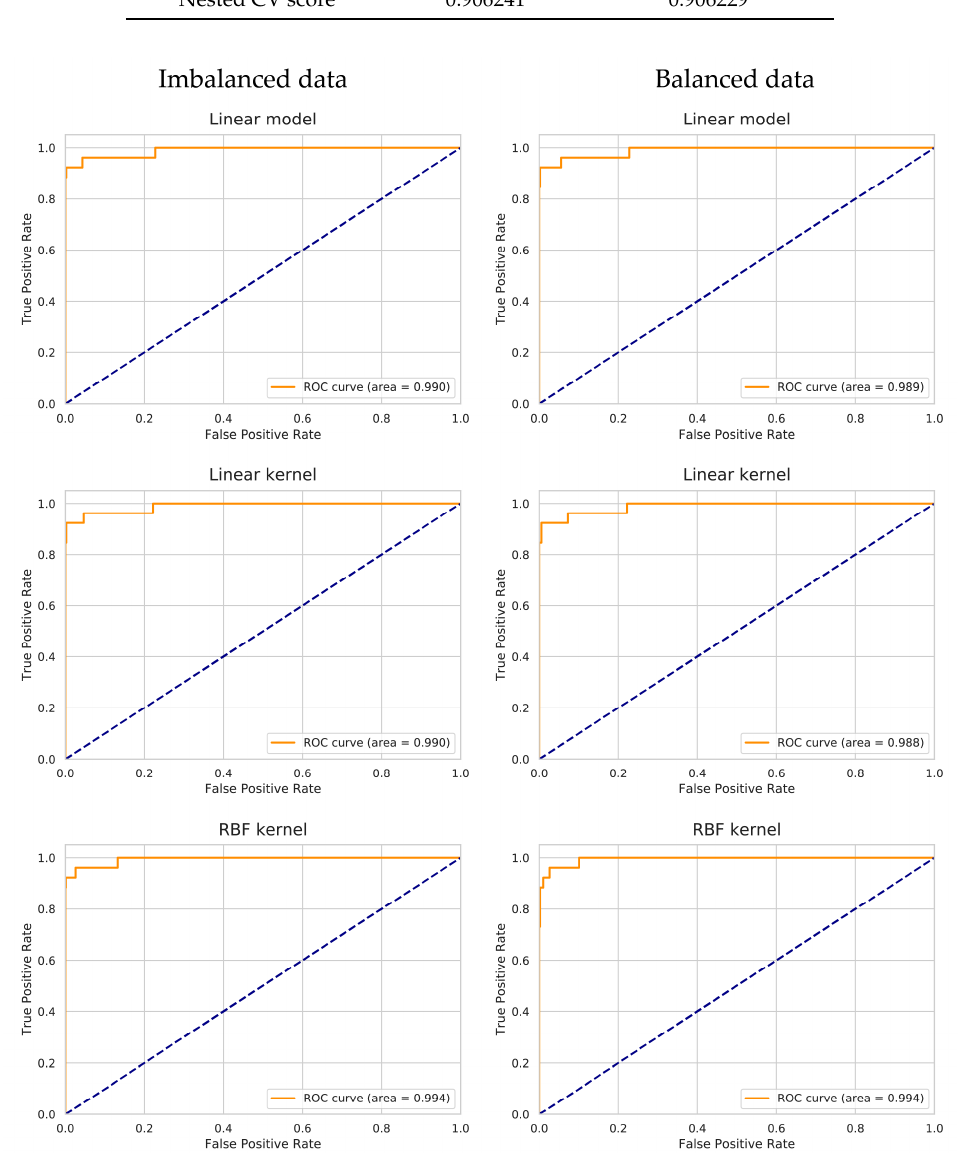
Figure 5. Receiver operating characteristic (ROC) curves and area under the curve (AUC) scores for each of the models tested in the second stage grid-search for both the imbalanced and balanced data. To analyze and compare in detail the accuracy performance on each class the confusion matrices were computed for the Linear-SVM (Figure A1) and the RBF-SVM (Figure 6). The UA and PA were computed considering the respective confusion matrix and are presented in Table 5.